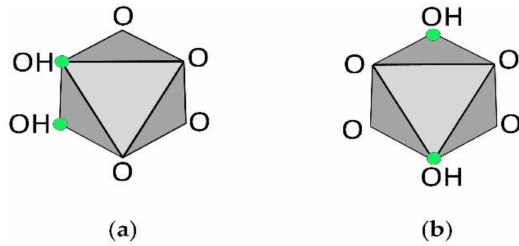
Figure 1. General structure of smectites.